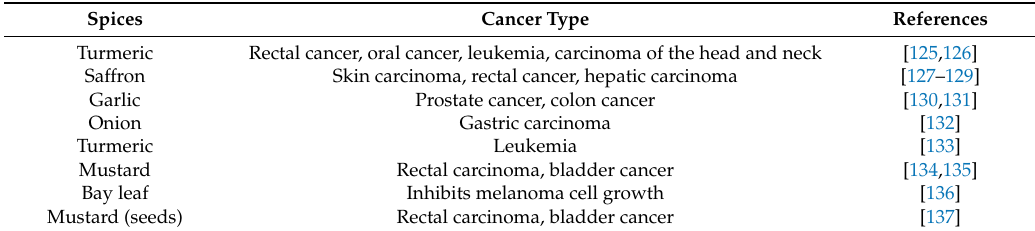
Table 5. Spices against